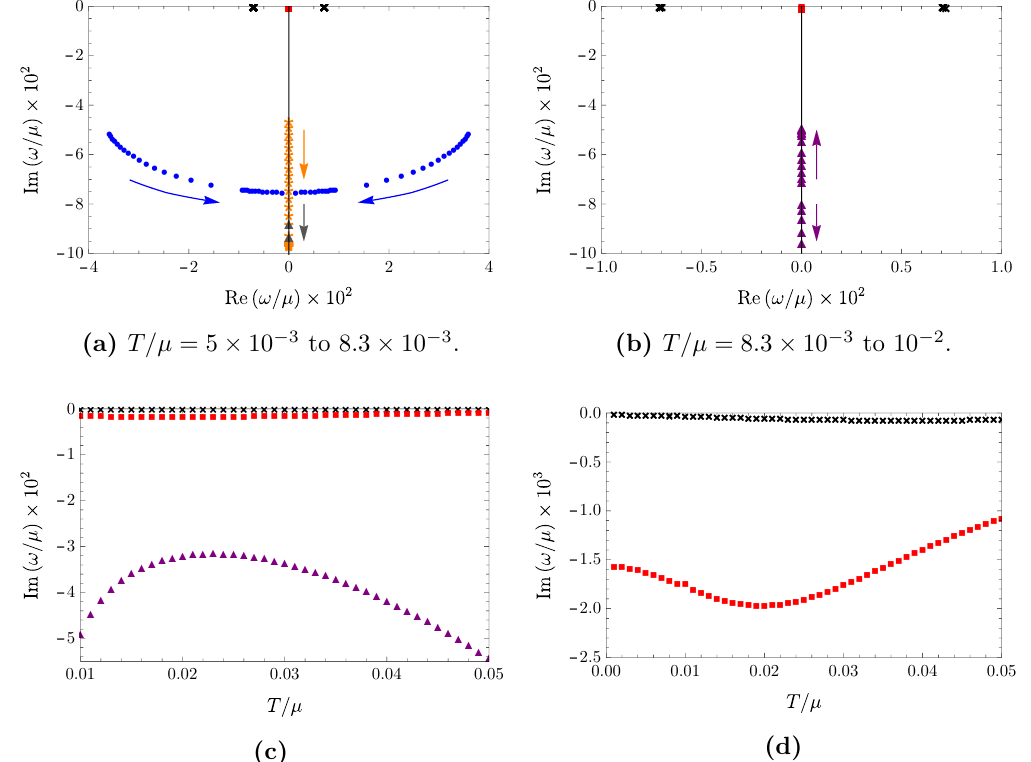
Figure 8. Positions of poles of G J and G tt in the complex !=(cid:22) plane with (cid:28) = 10 (cid:0) 2 , ~ (cid:11) = 1, k=(cid:22) = 10 (cid:0) 2 , and (a) 5 (cid:2) 10 (cid:0) 3 (cid:20) T=(cid:22) (cid:20) 8 : 3 (cid:2) 10 (cid:0) 3 and (b) 8 : 3 (cid:2) 10 (cid:0) 3 (cid:20) T=(cid:22) (cid:20) 10 (cid:0) 2 . We have enhanced Re ( !=(cid:22) ) and Im ( !=(cid:22) ) by 10 2 for clarity. Arrows indicate the movement of poles as T=(cid:22) increases. At T=(cid:22) = 5 (cid:2) 10 (cid:0) 3 we (cid:12)nd seven highest poles, the three highest being two HZS poles (black crosses) and a purely imaginary pole (red square), and four lower poles, two purely imaginary (orange and gray triangles), and two with non-zero real parts (blue dots). As T=(cid:22) increases the three highest poles barely move, while the orange and gray triangles move down. The blue dots move down and collide on the imaginary axis, above the orange and gray triangles, and then split into two purely imaginary poles (purple triangles), one moving up the axis and one moving down. However, unlike the previous smaller (cid:28) cases, the one moving up does not become the charge di(cid:11)usion pole, instead stopping, reversing direction, and moving back down the axis. The three highest poles eventually become the hydrodynamic sound and charge di(cid:11)usion poles, respectively. (c) Im ( !=(cid:22) ) (cid:2) 10 2 versus T=(cid:22) for the four highest poles, showing the upper purple triangle’s highest point at T=(cid:22) (cid:25) 2 : 4 (cid:2) 10 (cid:0) 2 . (d) Close-up of (c) for the three highest poles, showing how little these move compared to the others. (Animated versions of these (cid:12)gures are available on this paper’s arxiv